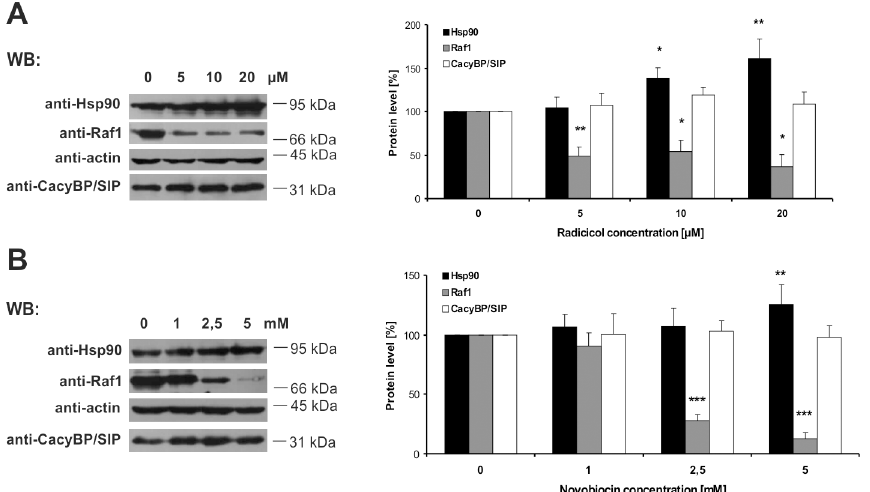
Fig 6. Influence of Hsp90 inhibition on CacyBP/SIP protein level. Level of CacyBP/SIP in HEp-2 cells treated with different concentrations of radicicol ( A ) or novobiocin ( B ). Representative Western blots (left panels) and densitometric analysis of data from 3 independent experiments (right panels) are shown as means ± standard errors (SEM); *** p (cid:1) 0.001, ** p (cid:1) 0.0.01, * p (cid:1)